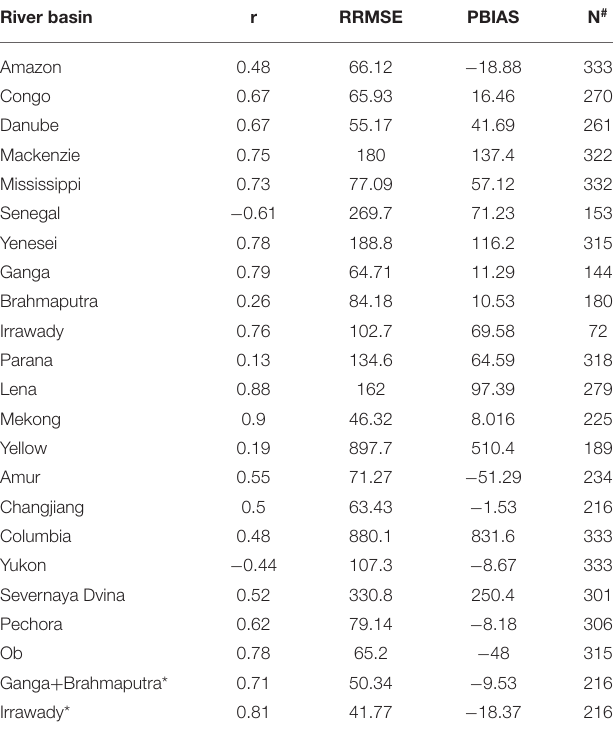
TABLE 1 | The correlation coefficient (r), relative root mean square error (RRMSE), and percentage bias (PBIAS) for the major river basins. N denotes the number of monthly observations conducted to compute the